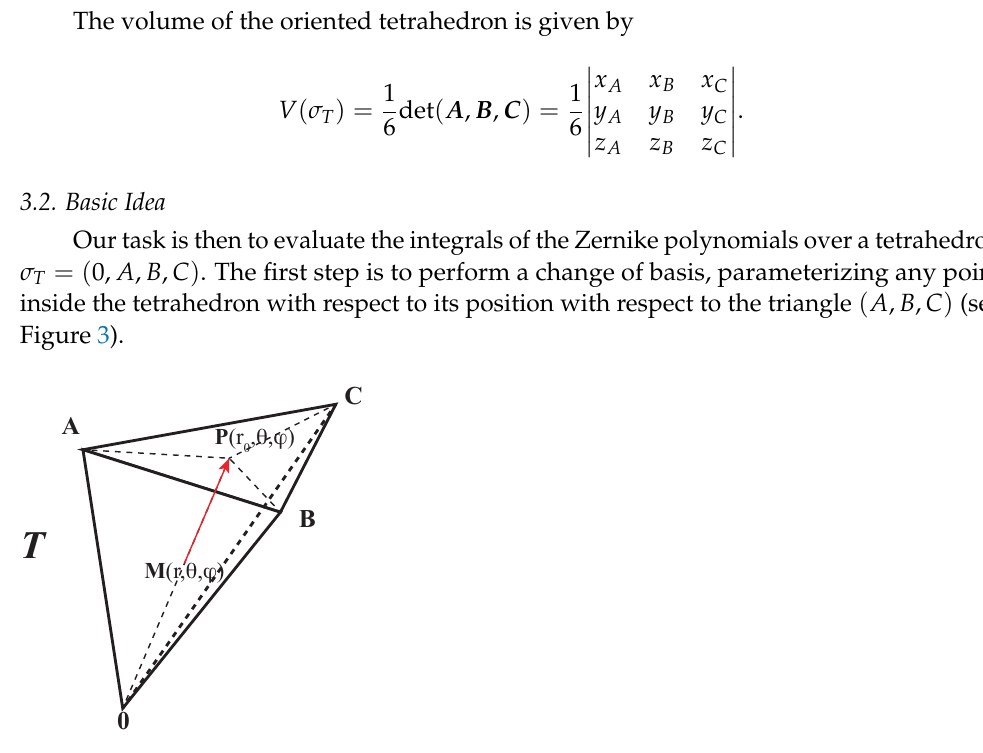
Figure 3. Parameterization of a tetrahedron . Let T = ( A , B , C ) be a triangle in the surface mesh, and σ T = ( 0, A , B , C ) be the associated tetrahedron where 0 is the origin. Any point M within σ T with spherical coordinates ( r , θ , φ ) is projected onto the triangle T to a new point P ( r 0 , θ , φ ) . Note that r 0 is a function of θ and φ